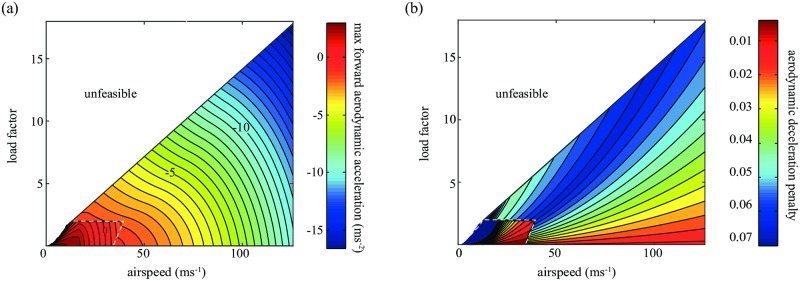
(a) Look-up table for the accelerations due to the aerodynamic forces acting on the falcon. At each model time-step, the falcon maximizes forward acceleration (minimizes deceleration), given its forward speed and with the constraint that load factor is set to achieve the net commanded acceleration by the guidance law. If this constraint cannot be met (i.e. if it is unfeasible due to aerodynamics or high resulting torque forces), the closest approximation of the load factor is chosen. In the blade-element model, the falcon optimizes the wing twist, the wing’s angle-of-attack, the wingbeat frequency and the wing retraction. Inside the trapezoidal contour, the falcon flaps at maximal wingbeat frequency, and outside it the falcon glides. Above the contour, flapping results in too high torque forces on the wing. Gravity is excluded from the accelerations in the figure. (b) The partial derivative of forward aerodynamic acceleration with respect to load factor, termed the “aerodynamic deceleration penalty”.